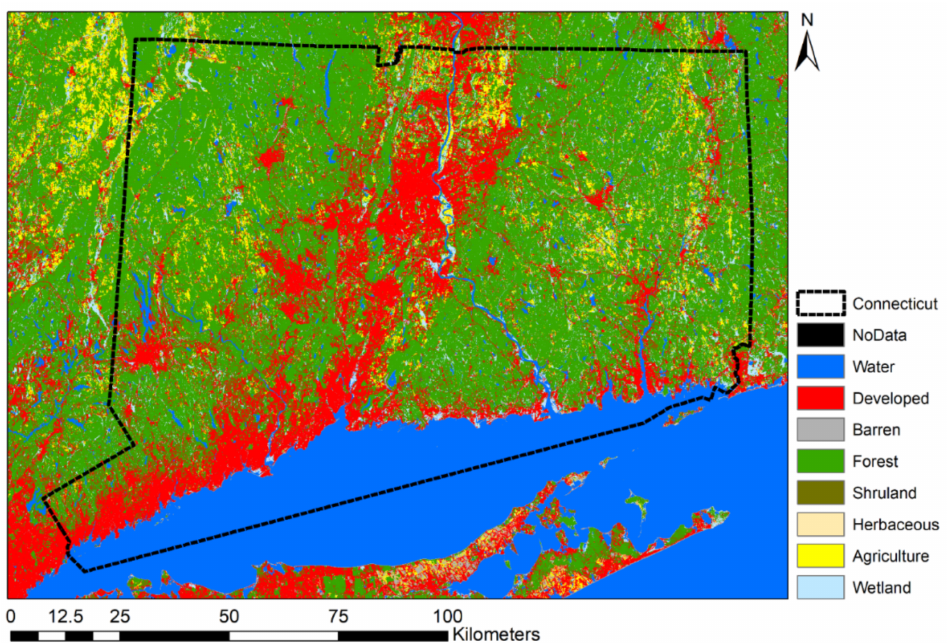
Figure 3. Land cover map (30 m) of Connecticut in 2018 generated from the Continuous Change Detection and Classification (CCDC) algorithm.